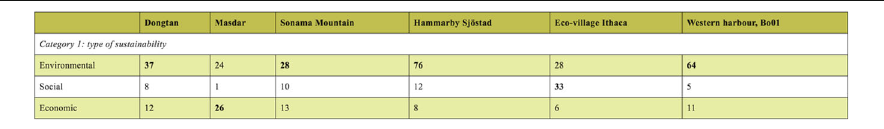
Source: Rapoport and Vernay